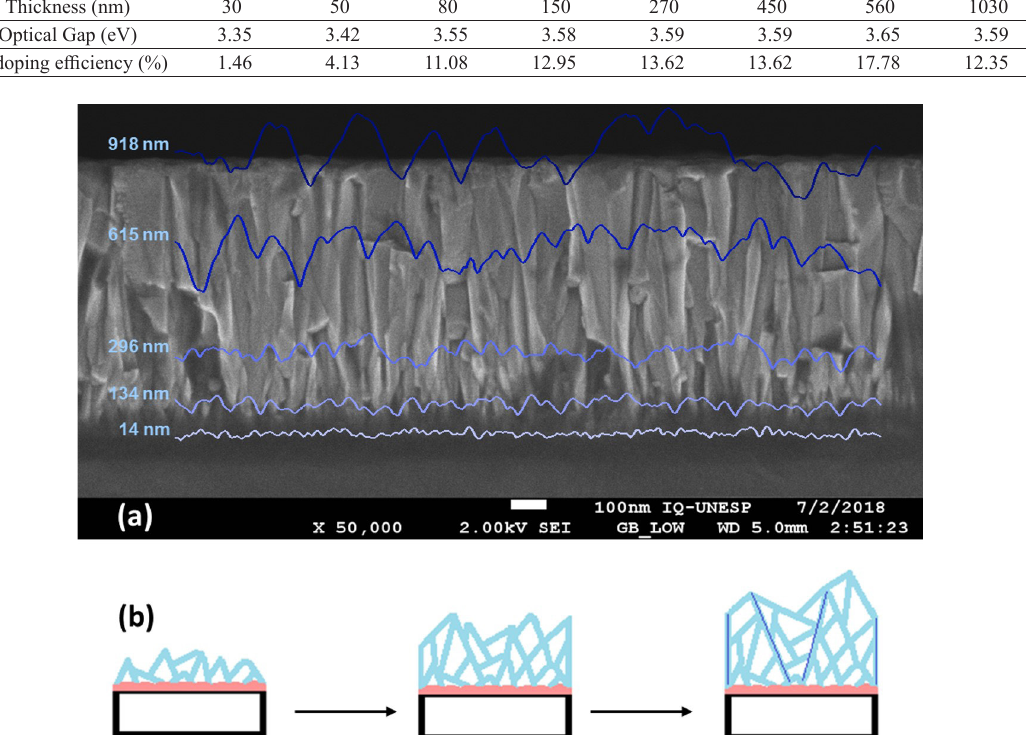
Table 1. Optical band gap calculated from the transmittance spectral data, and the Al-doping efficiency calculated from the RBS and Hall effect measurements as a function of film thickness. Thickness (nm)